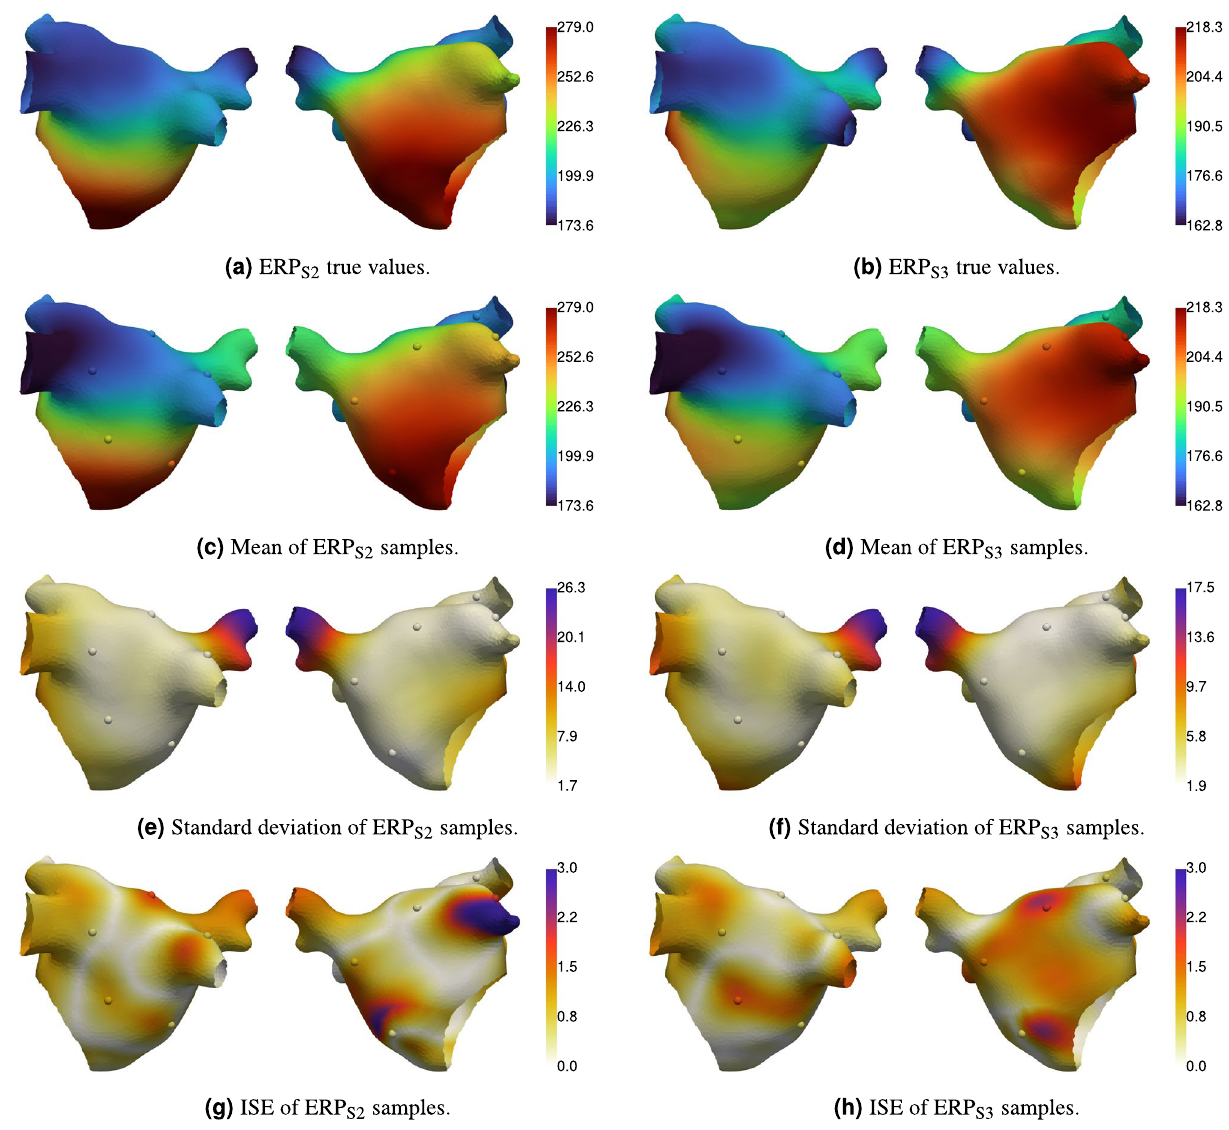
Figure 4. Ground truth and predicted (posterior mean and standard deviation) ERP fields, and independent standard error (ISE) plots comparing predicted and ground truth ERP. The spheres show the location of ERP measurements. All units are